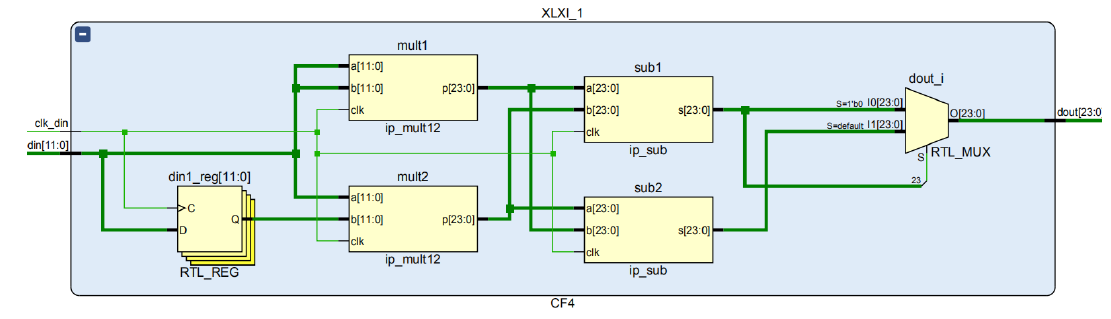
Figure 11. RTL diagram of the feature function module.